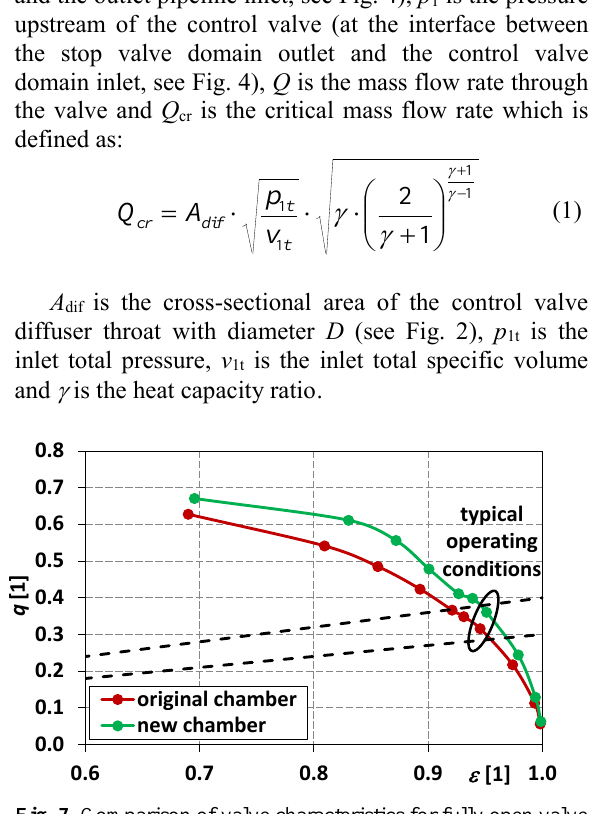
Fig. 7. Comparison of valve characteristics for fully open valve .